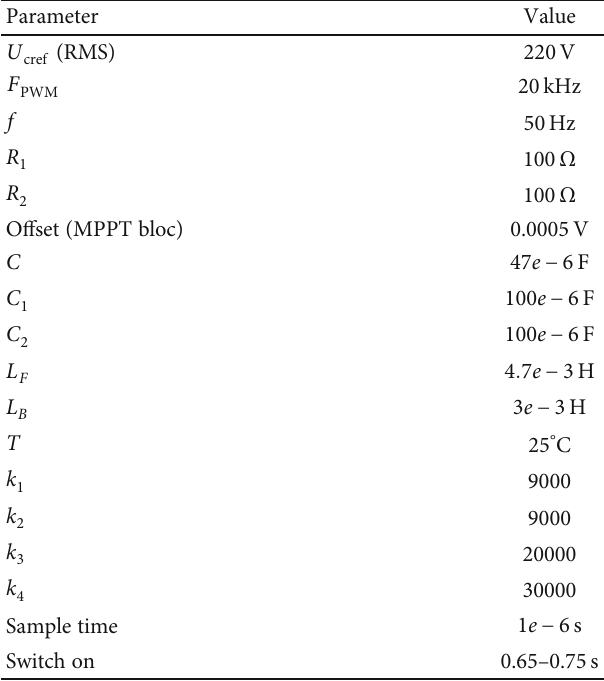
Table 2: Parameters of the system elements.